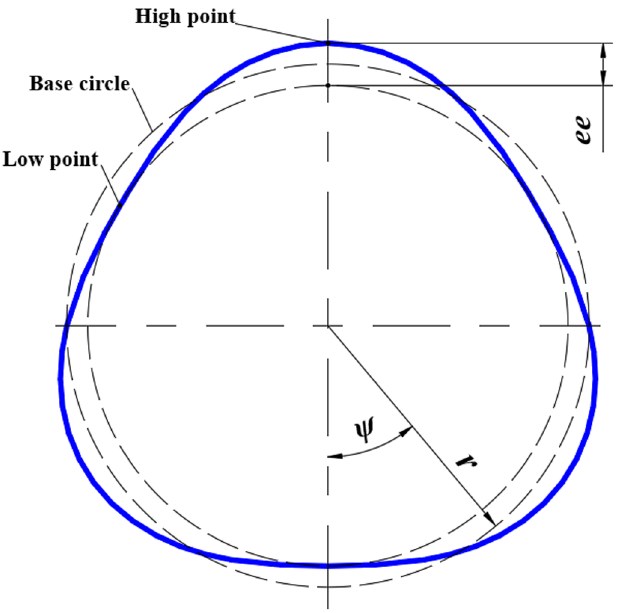
Fig. 1. The schematic diagram of the triple-lobe pro fi